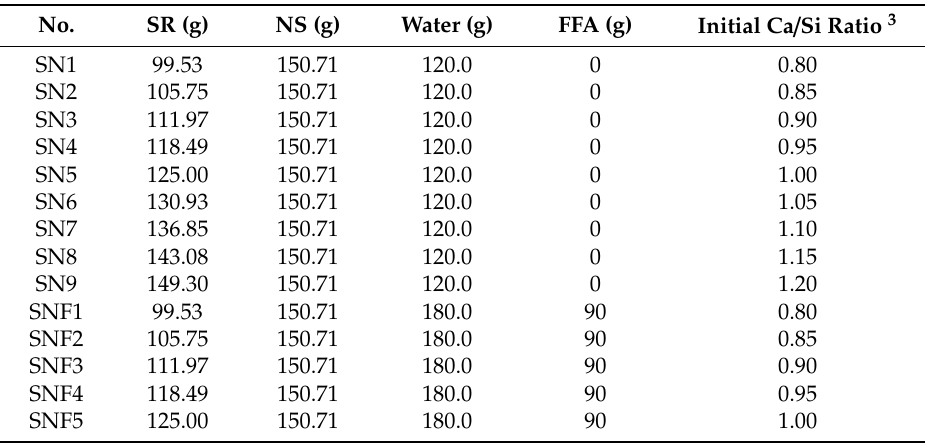
Table 3. Mass mixing proportions of backfill paste about the influence of Initial Ca / Si ratio on 7